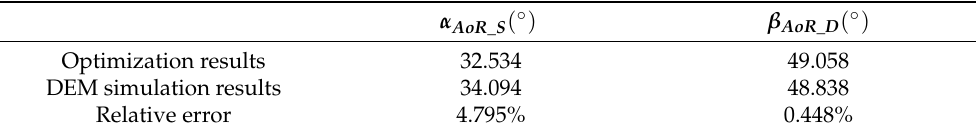
Table 9. Error analysis of the optimization results of the objective function.